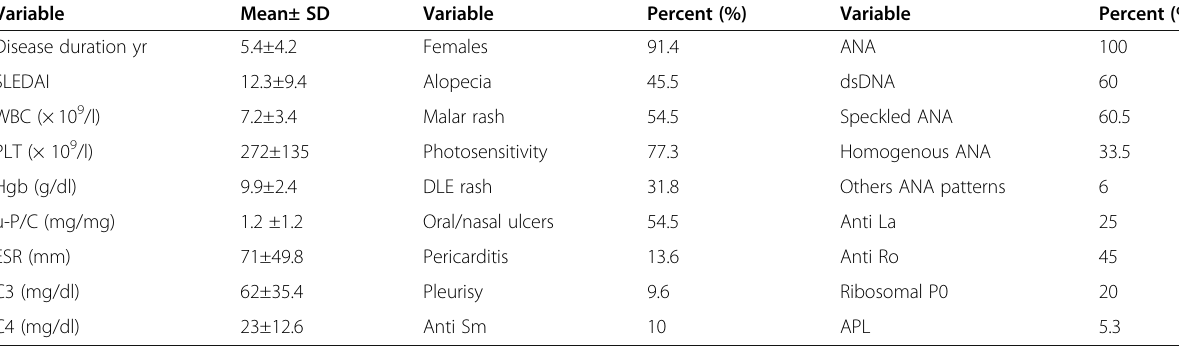
Table 1 The main demographic data for the patients Variable Mean± SD Variable Percent (%) Disease duration yr 5.4±4.2 SLEDAI